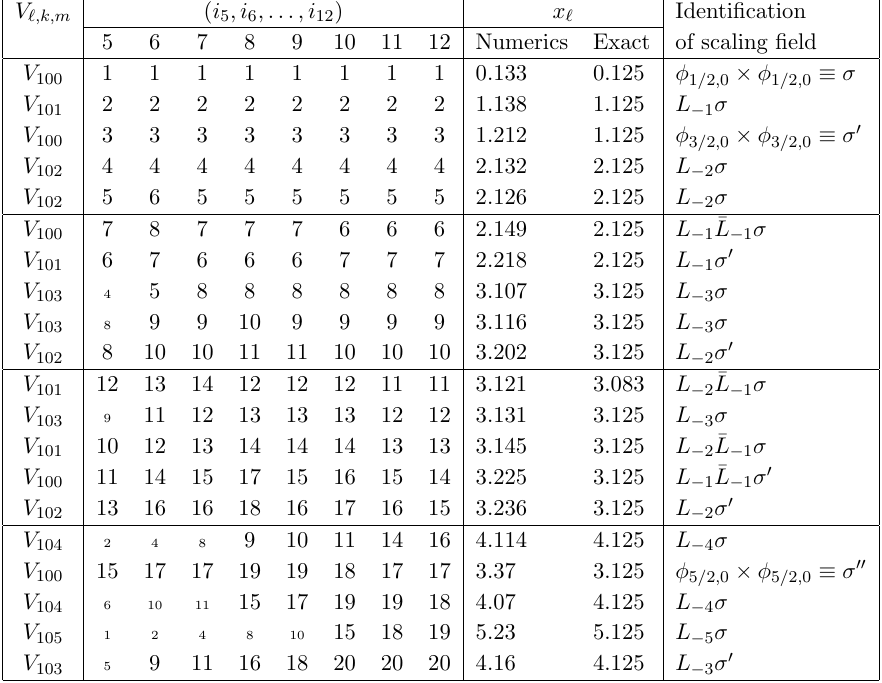
Table 5 . Conformal spectrum in the sector V 1 , for Q =